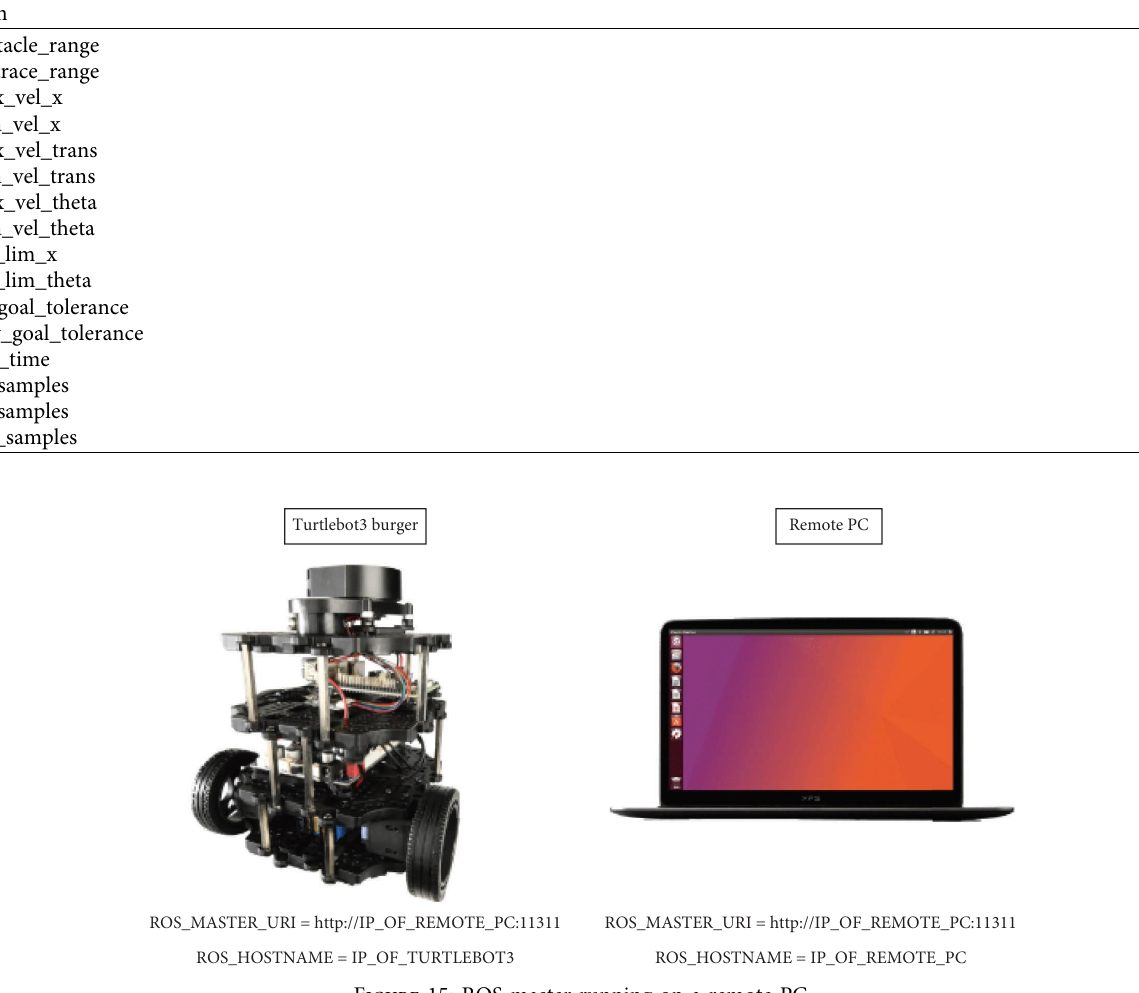
Figure 15: ROS master running on a remote PC.